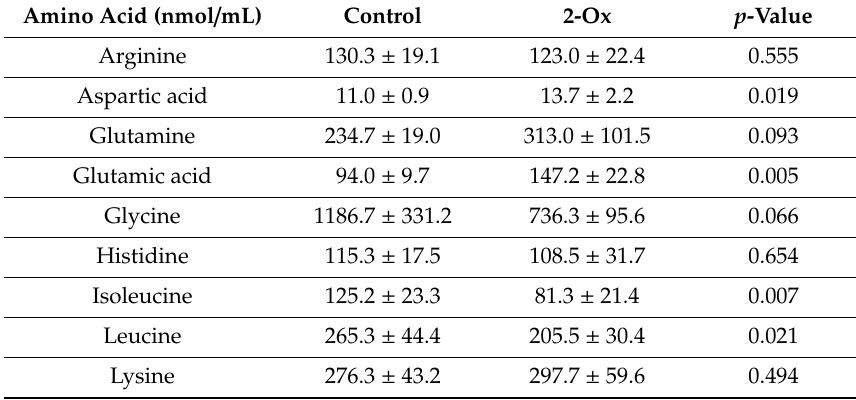
Table 5. Free amino acid concentration in serum obtained from control and 2-Ox-administered, nine-month-old, growth-retarded